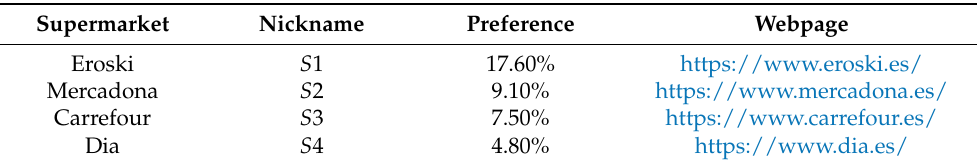
Table 1. Preference for e-grocery supermarkets.